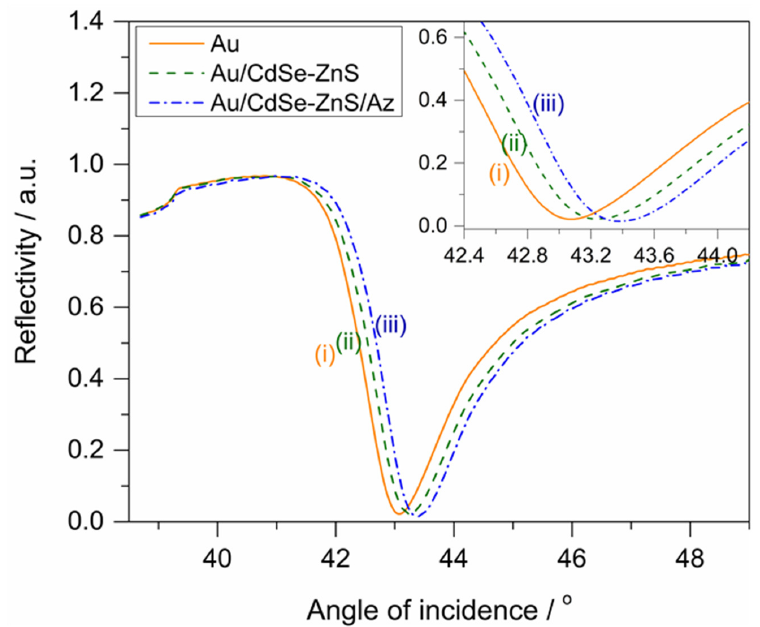
Figure 2. Sets of experimental SPR curves averaged over several locations on an electrode corresponding to ( i ) bare Au; ( ii ) CdSe-ZnS on Au; and ( iii ) Azurin/CdSe-ZnS/Au. Inset shows the zoomed portion of the reflective angle from 42.4° to 44.4 ° .